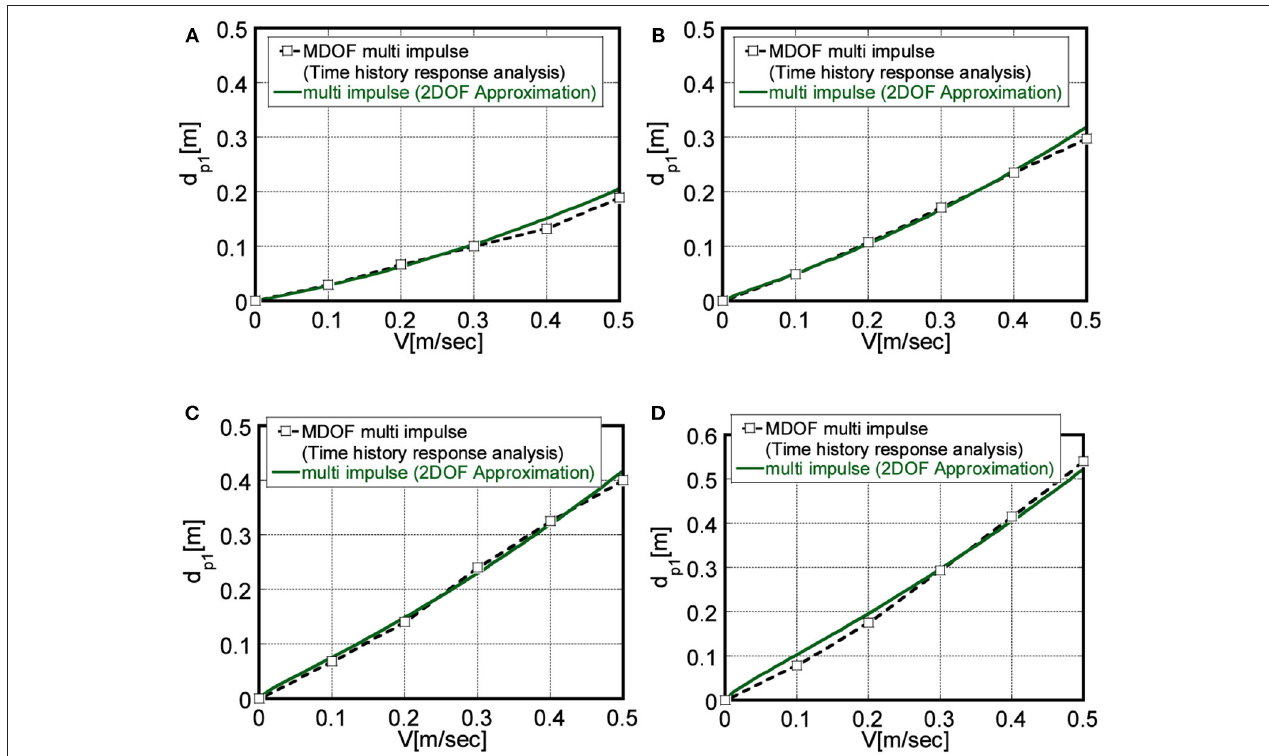
FIGURE 14 | Comparison of plastic deformation amplitude of base-isolation story by approximate solution for 2DOF model and that by time-history response analysis for original model, (A) N = 10, (B) N = 20, (C) N = 30, (D) N = 40.